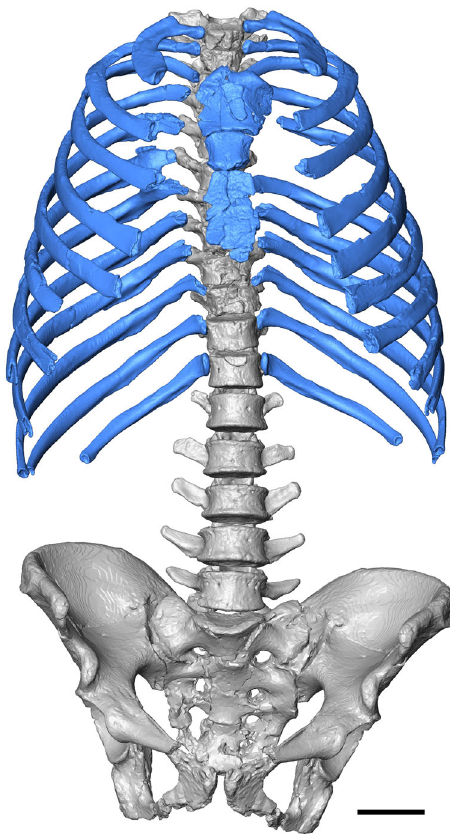
Fig. 1 Ventral view of the reconstructed thorax of Kebara 2. The blue color is to highlight the ribs and the sternum. Scale bar = 5